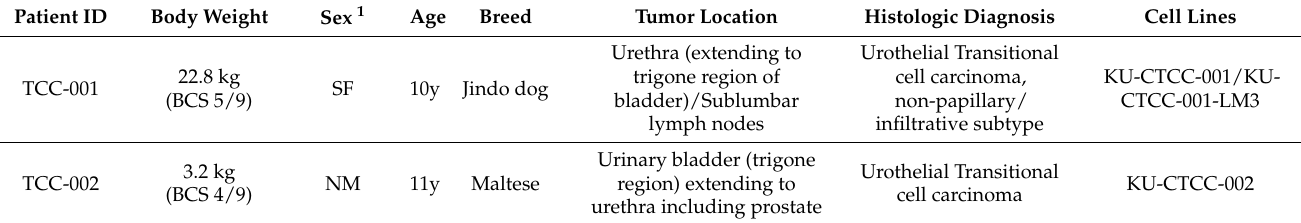
Table 1. Patient information.